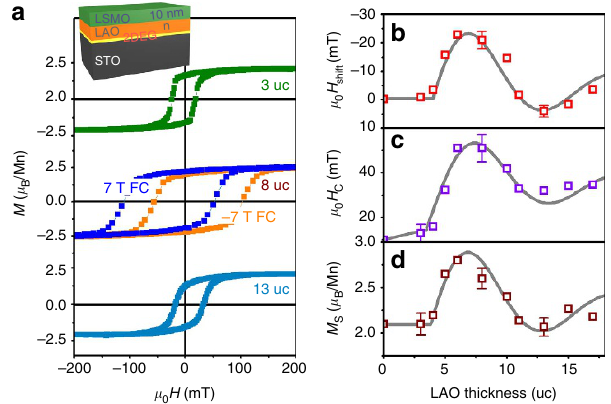
Figure 1 | Oscillatory behaviour in La 0.67 Sr 0.33 MnO 3 /LaAlO 3 /SrTiO 3 heterostructures. ( a ) At 10K, hysteresis loops with different LaAlO 3 thickness after 7T field cooling; a reverse case is shown in second panel. ( b – d ) The horizontal shift of the M–H loop ( H shift ), coercivity ( H c ) and saturation magnetization ( M s ) as a function of insulator thickness, measured as a multiple n of the unit cell (uc) parameter (0.39nm). The solid lines in b – d are all fits to a exponentially damped sinusoidal oscillation with period n (cid:2) 9u.c. and attenuation length n ¼